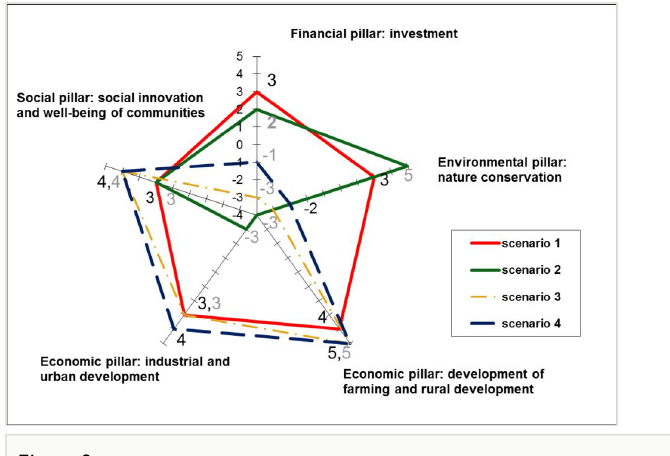
Figure 3. Stakeholder evaluation of forestry changes in the Clashindarroch